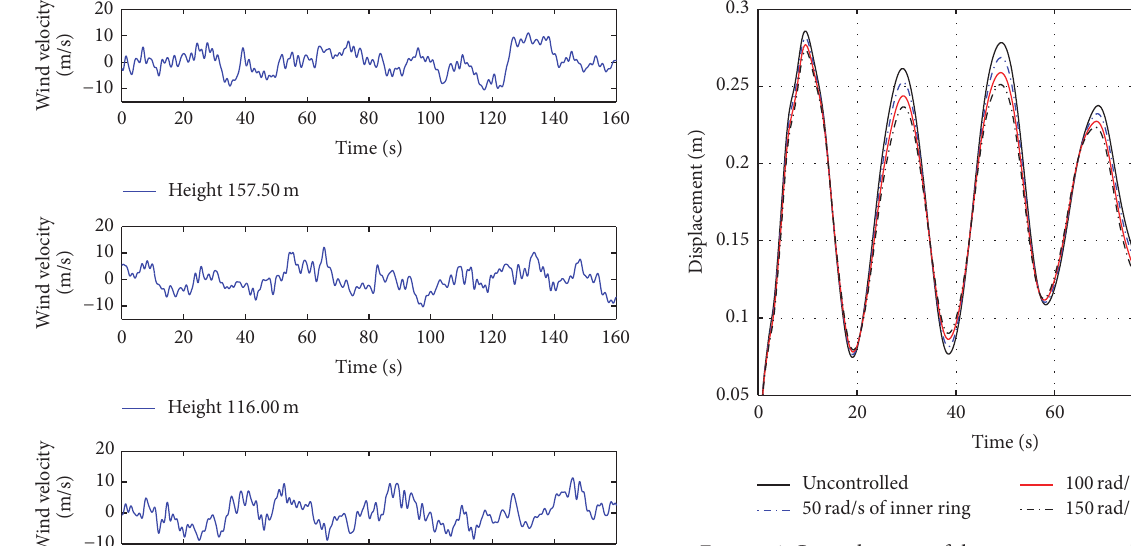
Figure 6: Control curves of the tower turret under wind